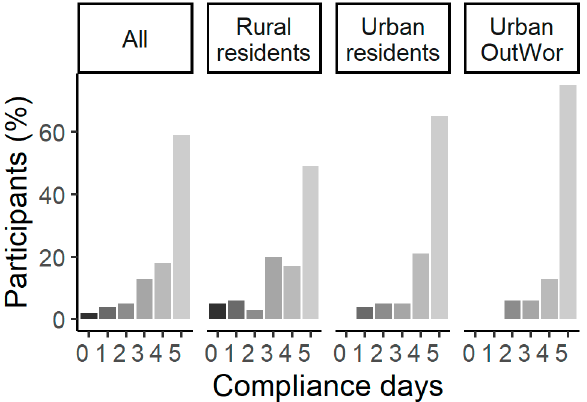
Figure 1. Intervention compliance days of participants. Participants (%) = number of participants/total participants × 100% in each compliance days category. Compliance days were days that participants carried out the intervention on Days 3–7 in the study. Pearson’s Chi-square tests showed the that there was significant difference in the distribution of compliance of person-days between Rural residents and Urban residents (Chi-Square = 7.99, Degrees of Freedom = 3, p -value = 0.046), but no significant difference between Urban residents and Urban OutWor (Chi-Square = 3.29, Degrees of Freedom = 3, p -value = 0.35).